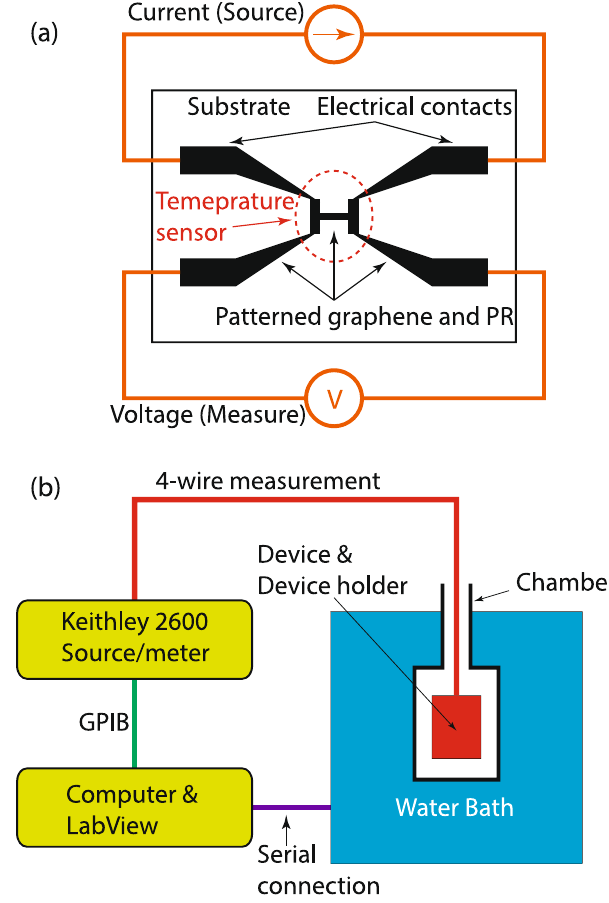
Figure 2. Measurement setup for characterizing the temperature response of micro-fabricated SLG temperature sensors. ( a ) Graphene device is displayed with a 4-wire resistance measurement setup. The device pattern design allows use of a 4-wire measurement to define the active temperature sensitive region of the device. ( b ) The temperature controlled test environment and measurement setup.